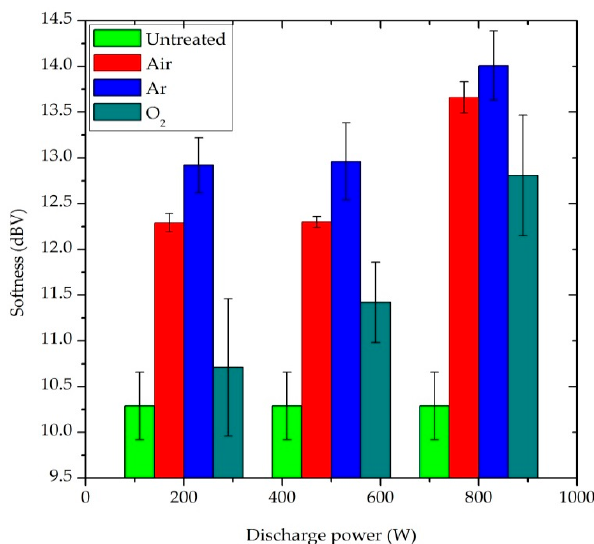
Figure 7. E ff ect of plasma treatment on the softness property of P / C blend fabric.